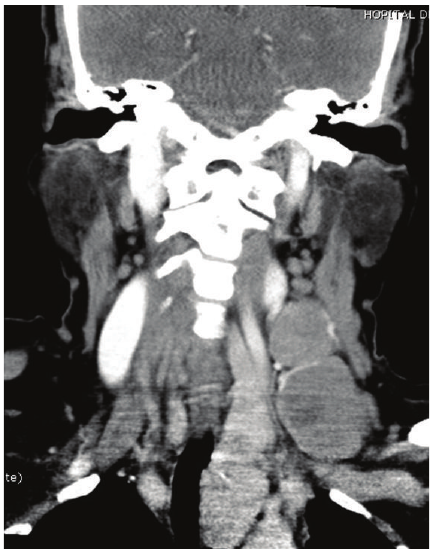
Figure2:ContrastenhancedneckCTscancoronalcup:heterogenic left lateral tracheal tissue mass, probably a left diving thyroid nodule with 2 voluminous left lymphadenopathies with heterogenic density and no calcifications.